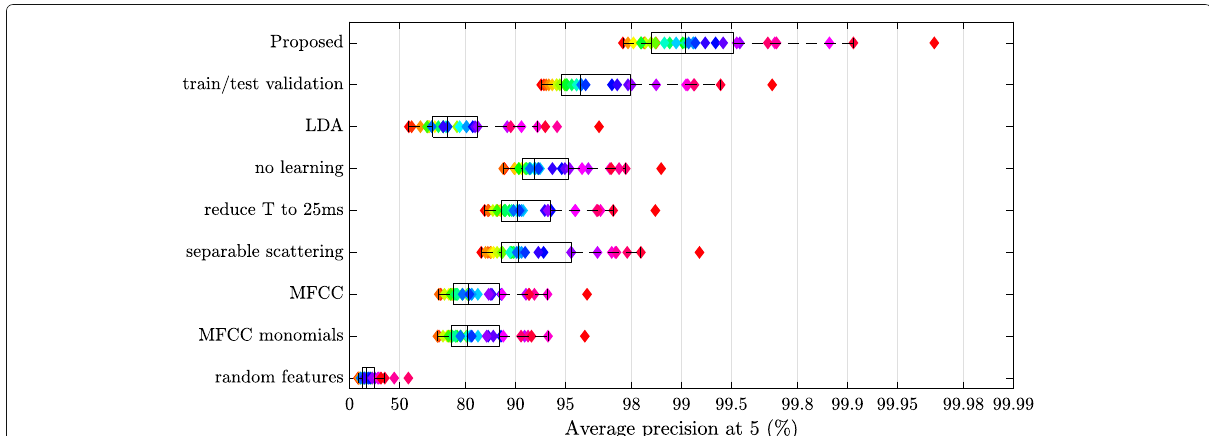
Fig. 5 Impact of different processing architecture or protocol designs. For each condition, the central mark indicates the median, and the bottom and top edges of the box indicate the 25th and 75th percentiles, respectively. The performance achieved for each reference clustering is depicted by a lozenge whose color is chosen arbitrarily but consistently across conditions. See Section 5 for details